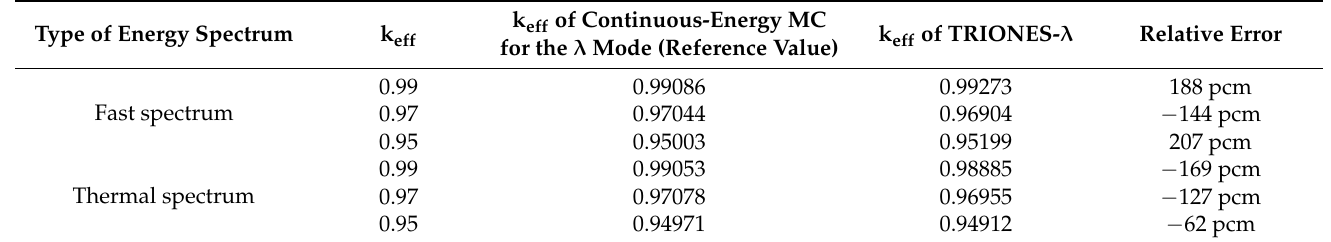
Table 4. The results of the verification of the homogenized group constants for the fast/thermal spectra of the ADSR in the λ